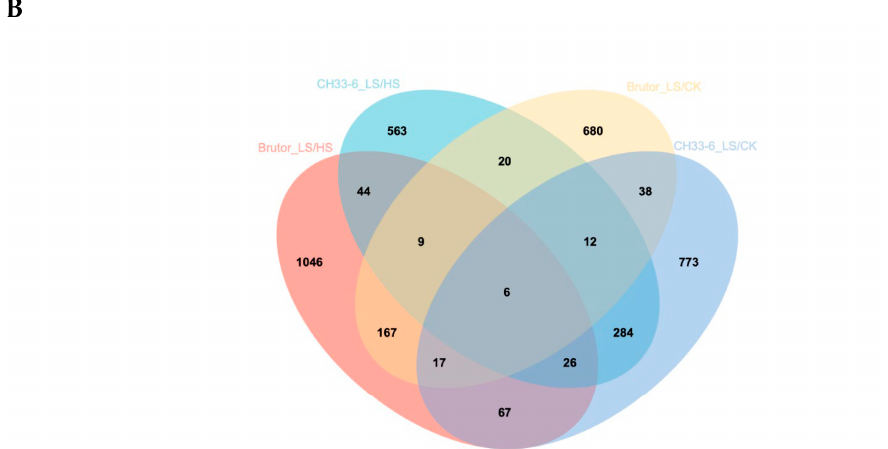
Figure 3. Statistical charts of the differentially expressed genes (DEGs) in two Brassica napus varieties (CH336 and Brutor) under control (CK, 0 mmol L − 1 NaCl), low salt (LS, 25 mmol L − 1 NaCl), and high salt (HS, 180 mmol L − 1 NaCl) stress conditions. ( A ). The column charts of DEGs in each comparison group. The pink and light blue colors indicate the up- and down-regulated DEGs, respectively. The numbers in the column refer to the DEG amounts in each comparison group. ( B ). Venn diagram showing the number of unique and common DEGs in both varieties.